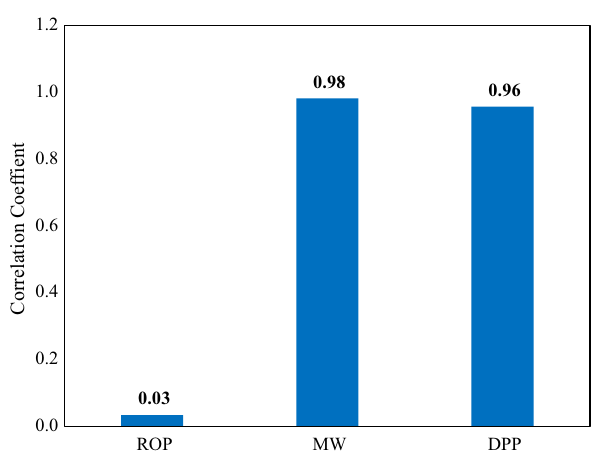
Fig. 11 The correlation coefficient between individual surface param- eters and the calculated ECD using the developed